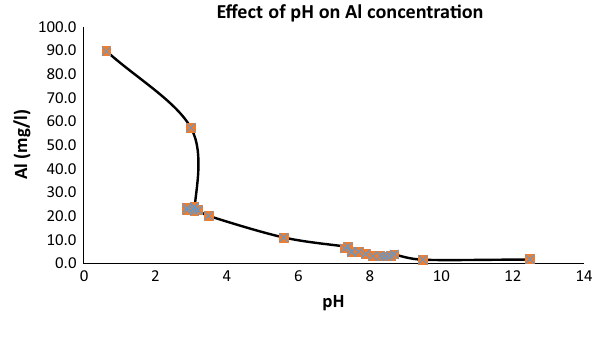
Fig. 1 Effect of pH on Al